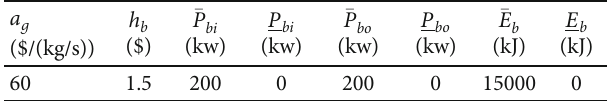
Table 8: Aircraft battery and generator